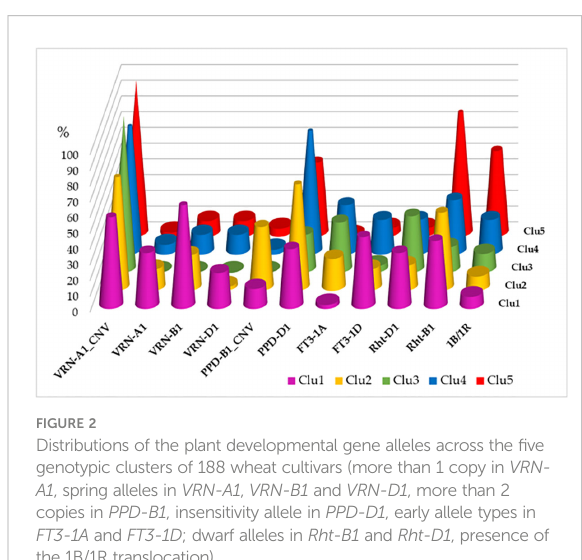
FIGURE 2 Distributions of the plant developmental gene alleles across the fi ve genotypic clusters of 188 wheat cultivars (more than 1 copy in VRN- A1 , spring alleles in VRN-A1 , VRN-B1 and VRN-D1 , more than 2 copies in PPD-B1 , insensitivity allele in PPD-D1 , early allele types in FT3-1A and FT3-1D ; dwarf alleles in Rht-B1 and Rht-D1 , presence of the 1B/1R